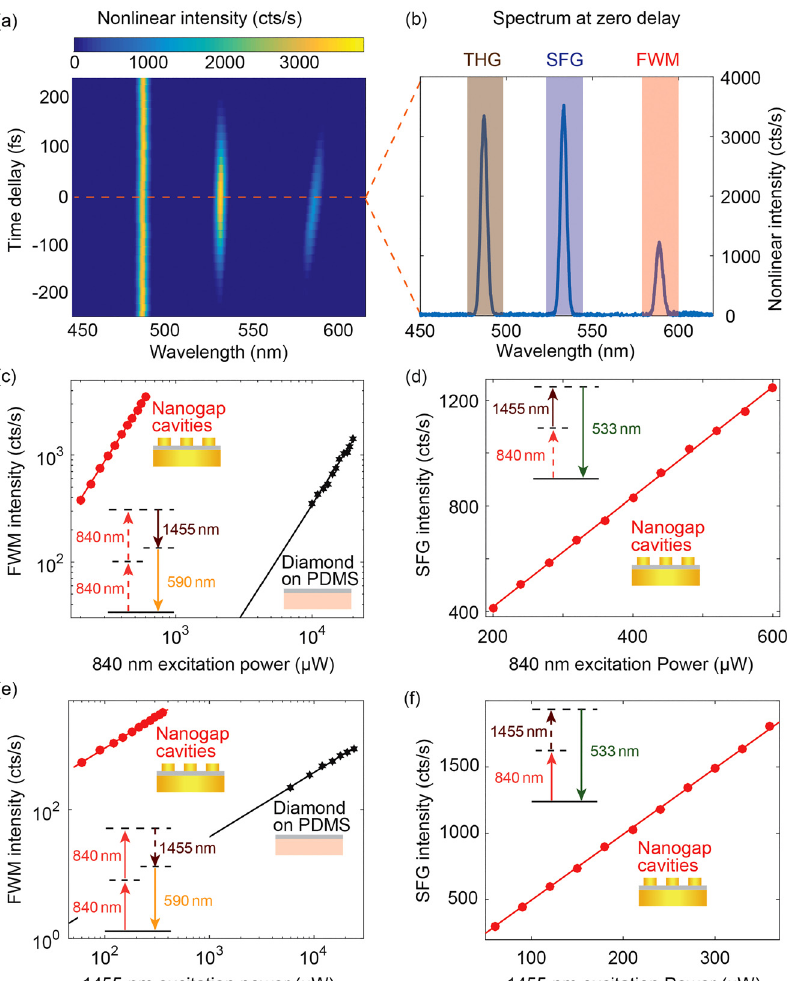
Figure 4: (a) The spectra of nonlinear responses as a function of the time delay between the two excitation pulses at 840 and 1455 nm. (b) Nonlinear response spectra at zero time delay. The three peaks correspond to THG, SFG and FWM as indicated in the fi gure. (c and d) Power dependence measurements for